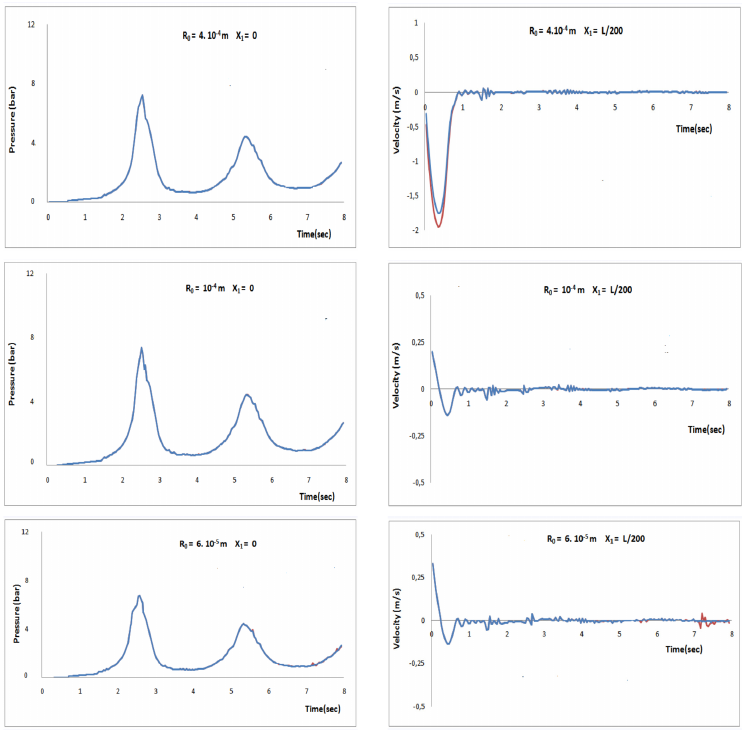
Figure 3. Comparison between the numerical schemes (4.2) and (4.3) for CO2/Water mixture with dissolved gas concentration